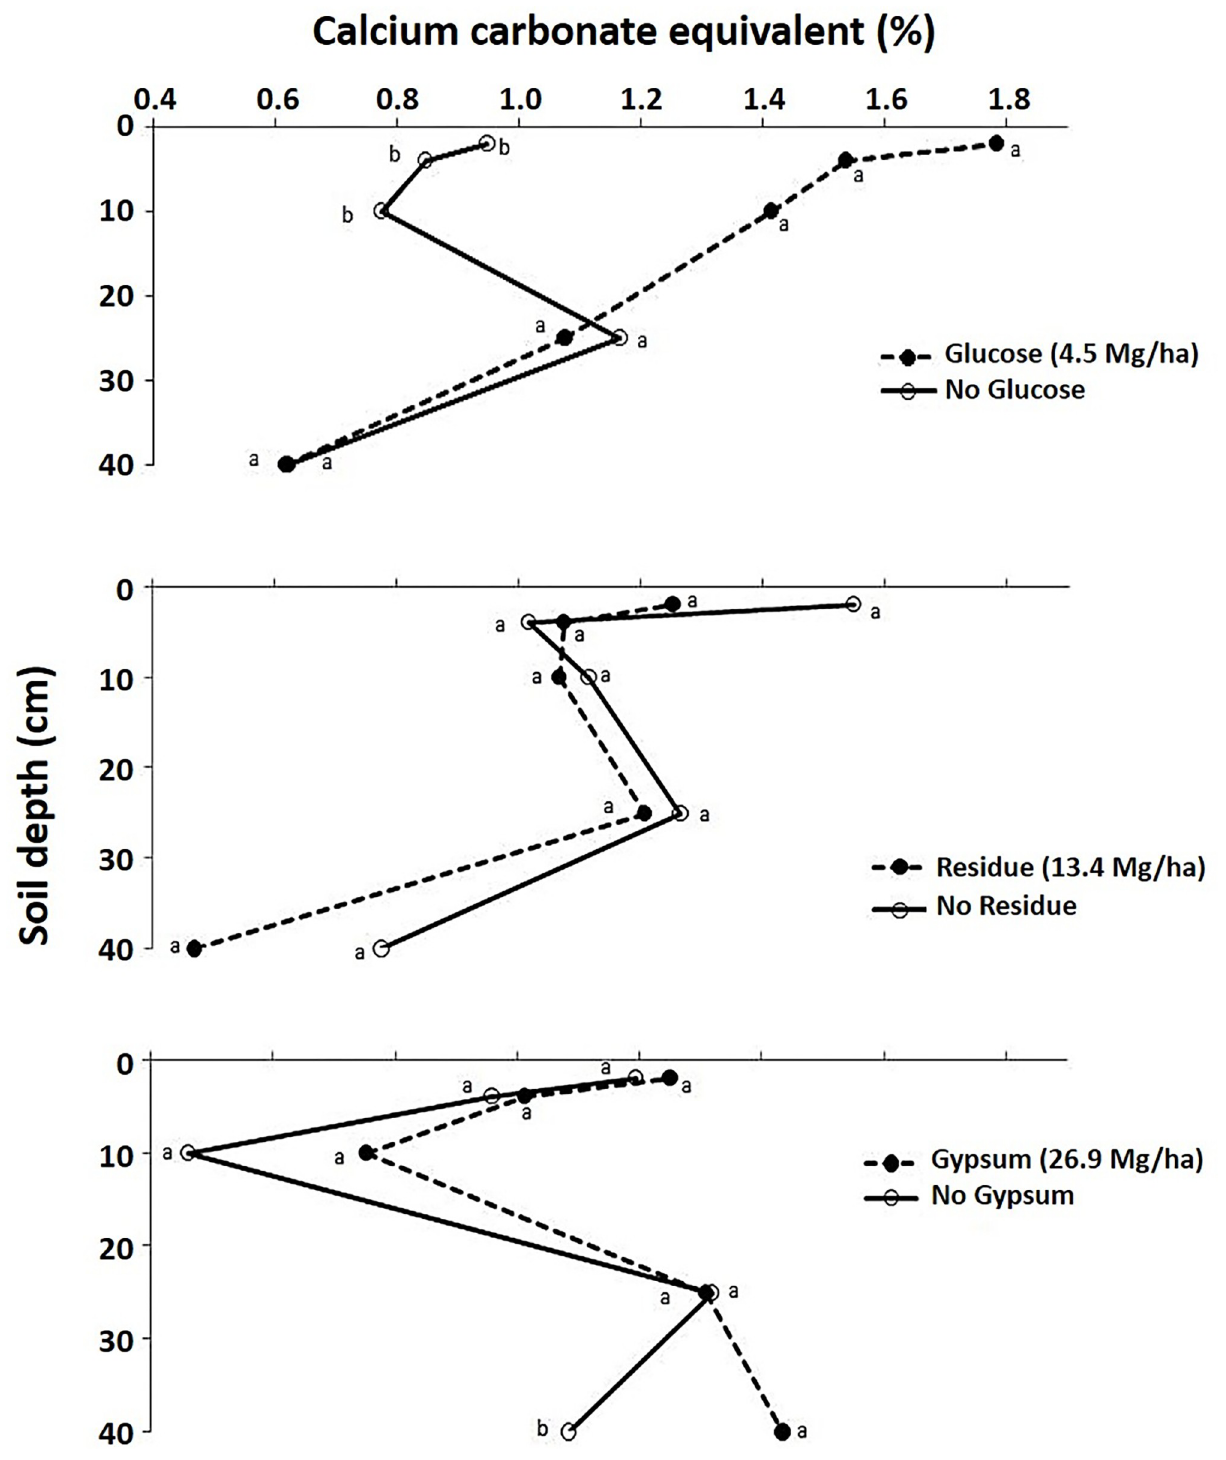
Fig 5. Effect of glucose, residue and gypsum addition on calcium carbonate equivalent concentrations (%) in different Hoytville soil layers. Means with the same letter within same layer are not statistically different (P < 0.10).